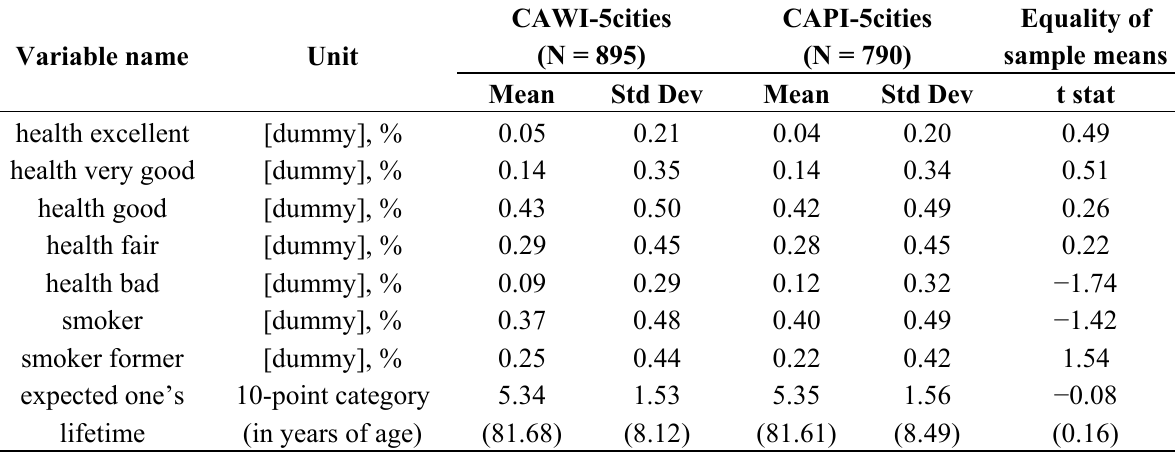
Table 4. Self-assessment of own health and age until when one most likely will